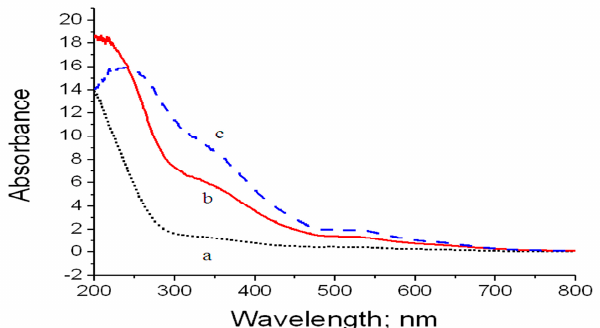
Figure 11. Absorbance of Co–Si LDHs: ( a ) pure, ( b ) after zirconium inclusion, and ( c ) after zirconium and titanium inclusion.